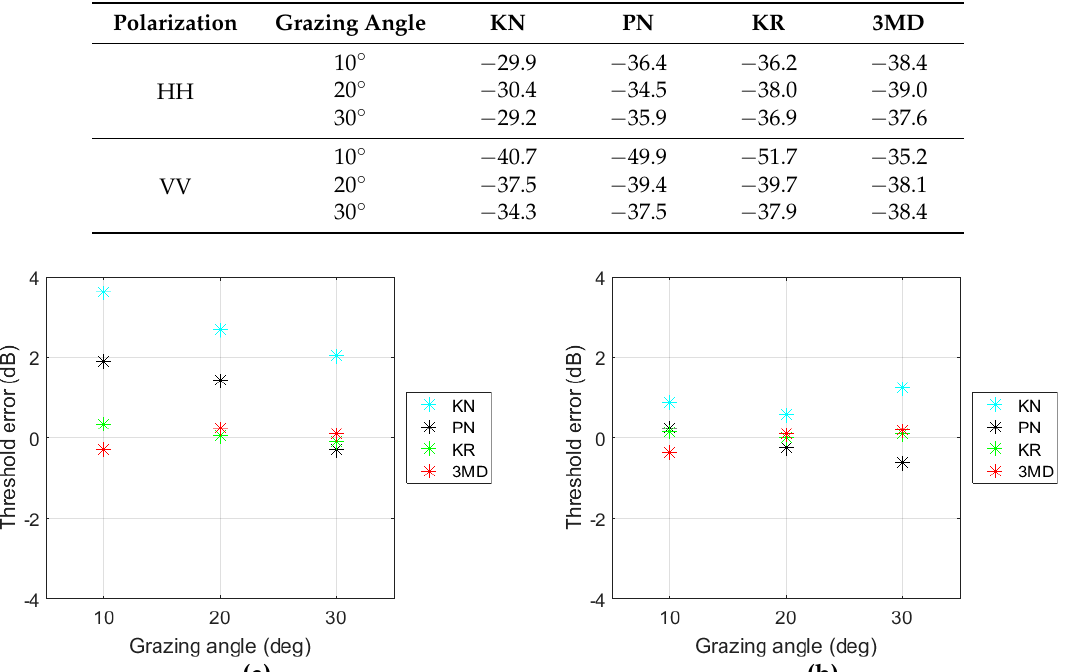
Table 11. SETHI X-band Run 3 (grazing 10°), Run 4 (grazing 20°), and Run 5 (grazing 30°). Bhattacharyya distance (values in dB) between experimental and fitted PDFs.